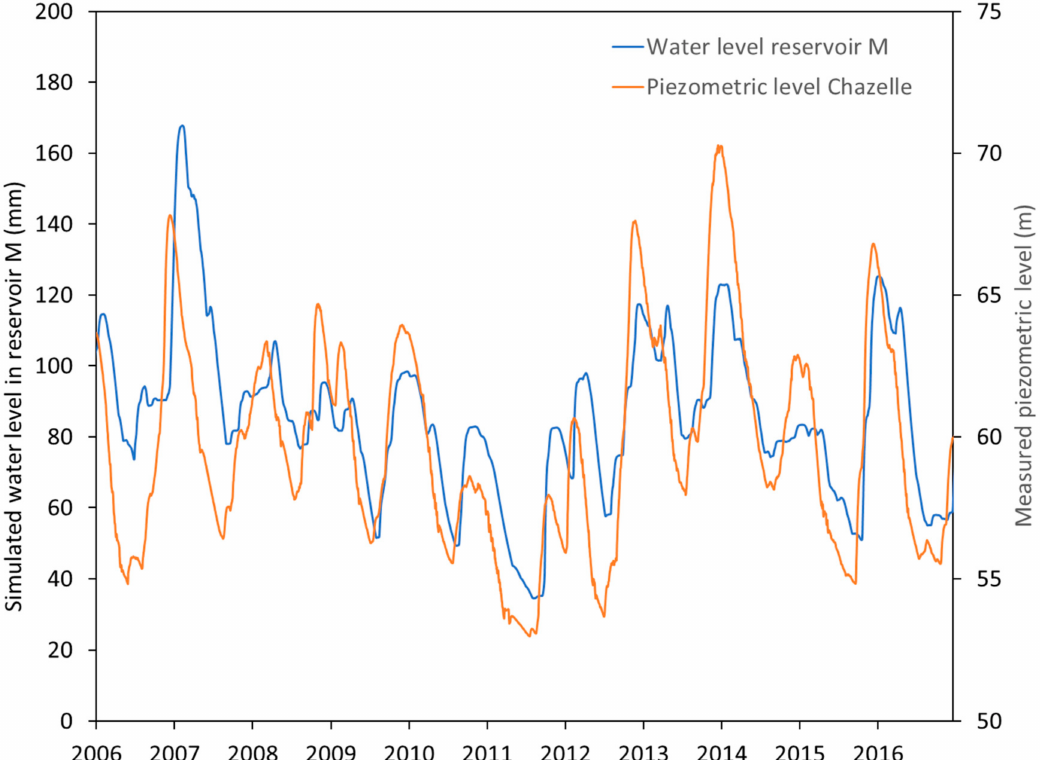
Figure 5. Comparison between the water level in reservoir M and the piezometric level observed at Chazelle